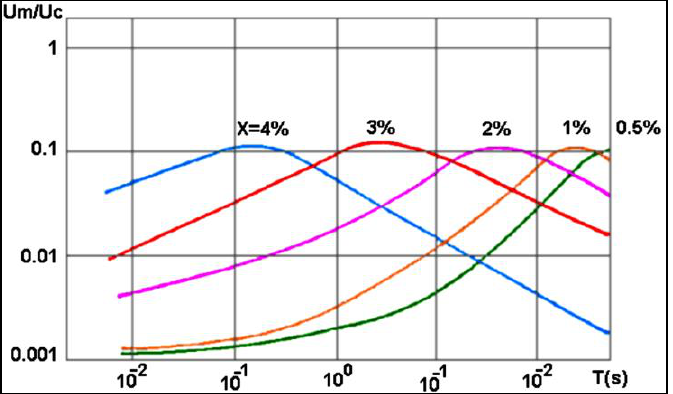
Figura 5: Dependencia del espectro de polarización con el grado de Humedad. Fuente: Autores, (2017).